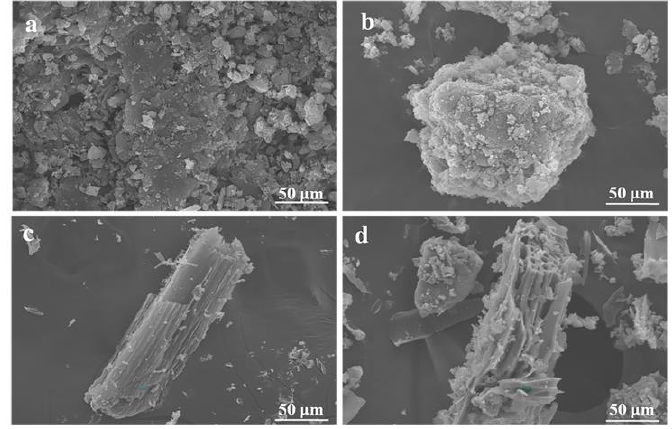
Figure 2. Scanning electron microscopy (SEM) images of ( a ) g-C 3 N 4 , ( b ) K-doped g-C 3 N 4 , ( c ) biochar and ( d ) biochar-supported K-doped g-C 3 N 4 .